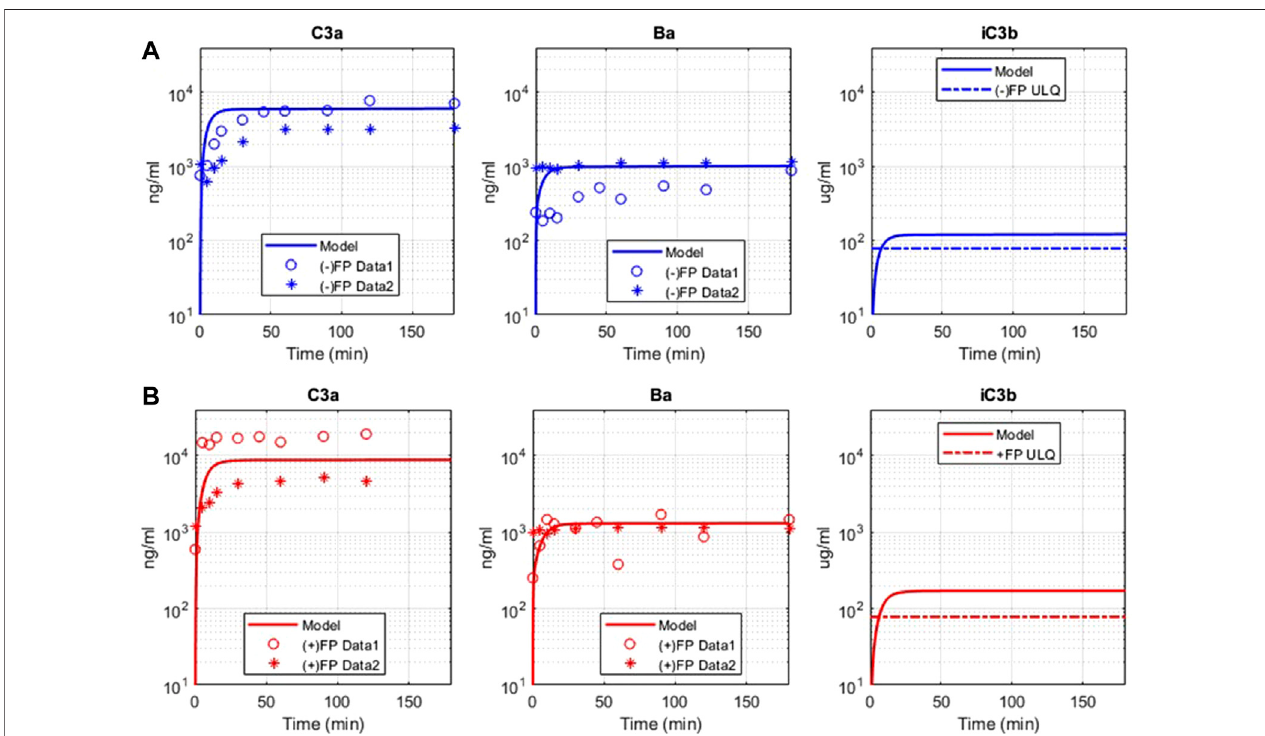
FIGURE5| ComparisonofmodelsimulationswithGSK invitro assaydataforalternativepathway.Modelresultsaredenotedbysolidline,andtheassayresultsare from twosetsofindependent, identicalexperiments, denoted as “ Data1 ” (o)and “ Data2 ” (*). (A) Modelsimulation and invitro dataforalternativepathway assaywithout Properdin ( − ) FP for C3a, Ba, iC3b. (B) Model simulation and in vitro data for alternative pathway assay with Properdin (+)FP for C3a, Ba, and iC3b.